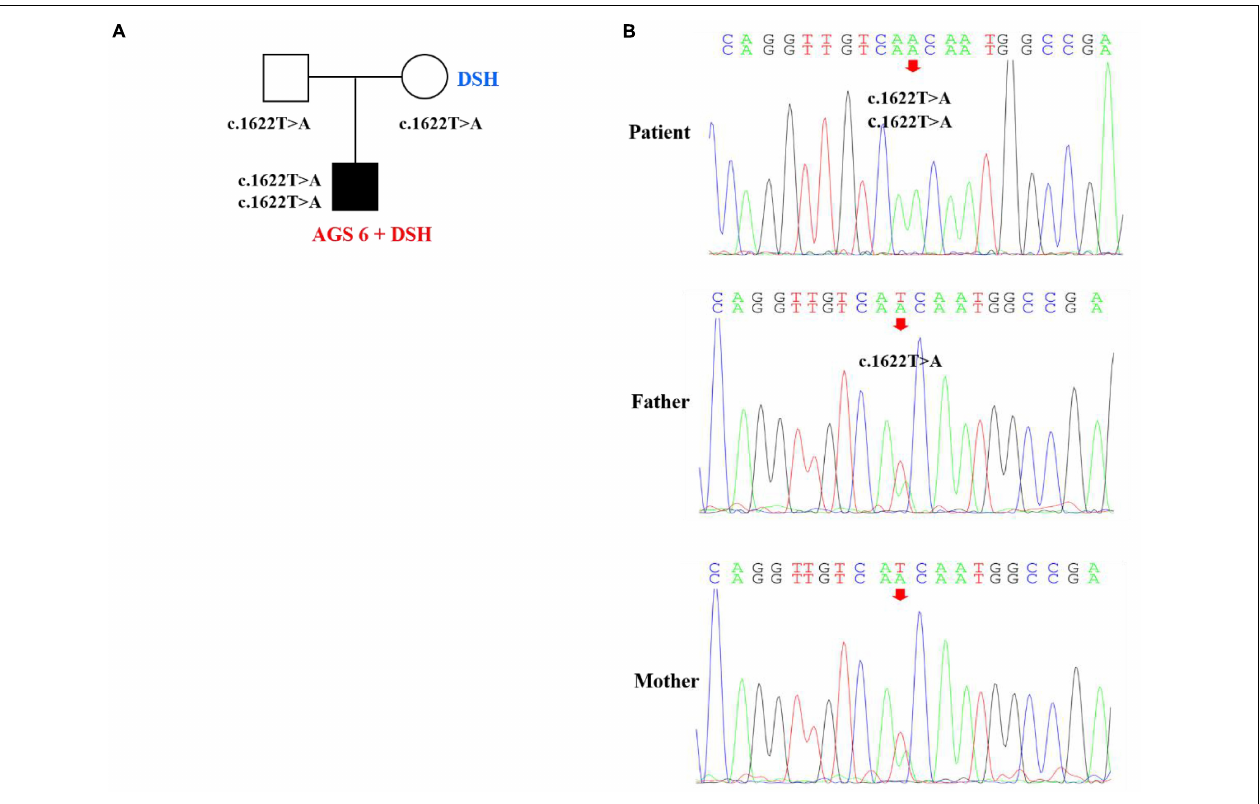
FIGURE 3 | Pedigree features of the patient with both dyschromatosis symmetrica hereditaria (DSH) and Aicardi-Goutières syndrome type 6 (AGS 6) and the causative ADAR1 mutation. (A) Pedigree with the identified ADAR homozygous mutation. (B) Sequencing verification results showed that the homozygous nucleotide variation of ADAR gene c.1622T > A of the patient caused amino acid 541 to change from Ile to Asn, which was missense mutation, and was inherited from his parents,